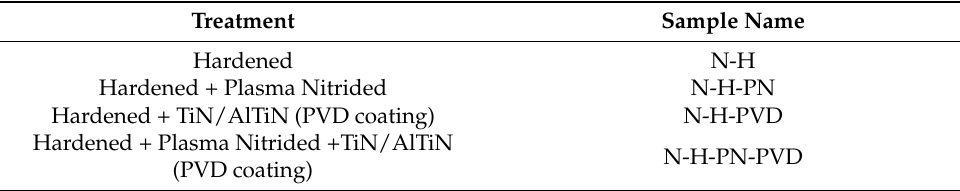
Table 2. Sample treatments and designated sample names.